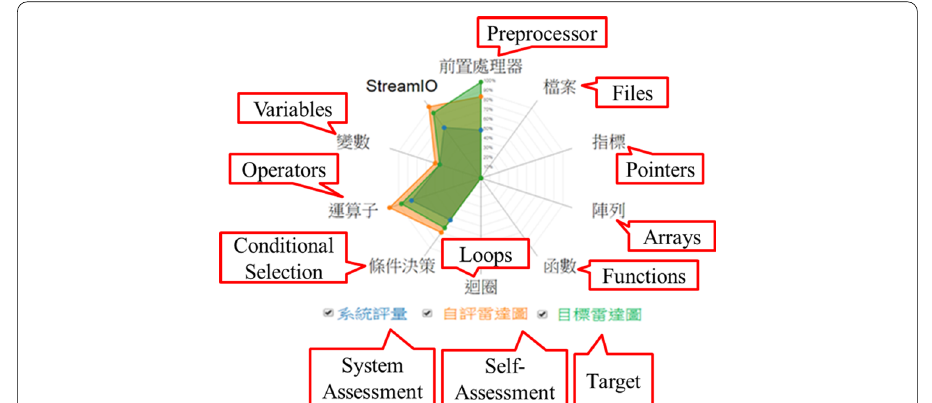
Fig. 7 Open learner models from the self‑assessment (orange), system assessment (blue), and target (green)